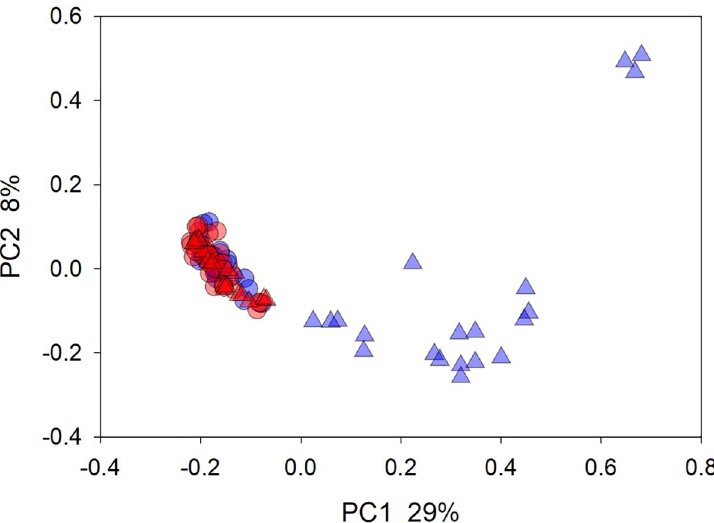
Fig 1. Principal coordinate analysis of all horses and all samples. The plot is based on weighted pairwise UniFrac distances between 97 samples. The distance between points is an approximate representation of the phylogenetic distance between 2 microbiota samples. Circles, 60 samples: 2 from each healthy old (n = 15) and from each young (n = 15) horse; blue circles, old; red circles, young; red triangles, FMT donors; blue triangles, FMT recipients.